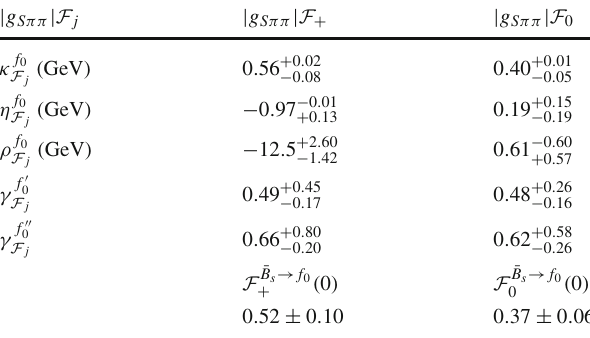
+ f (cid:4)(cid:4) 0 0